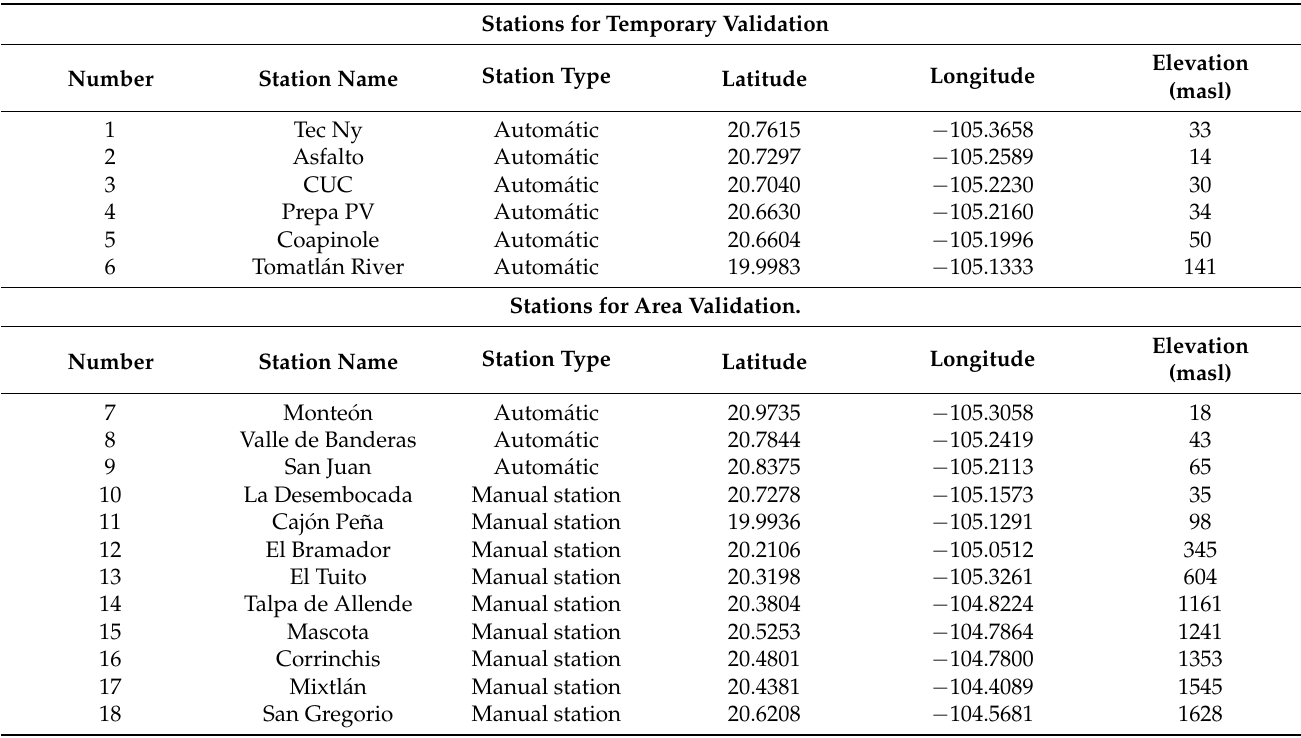
Table 1. Location of the stations used for validation (see Figure